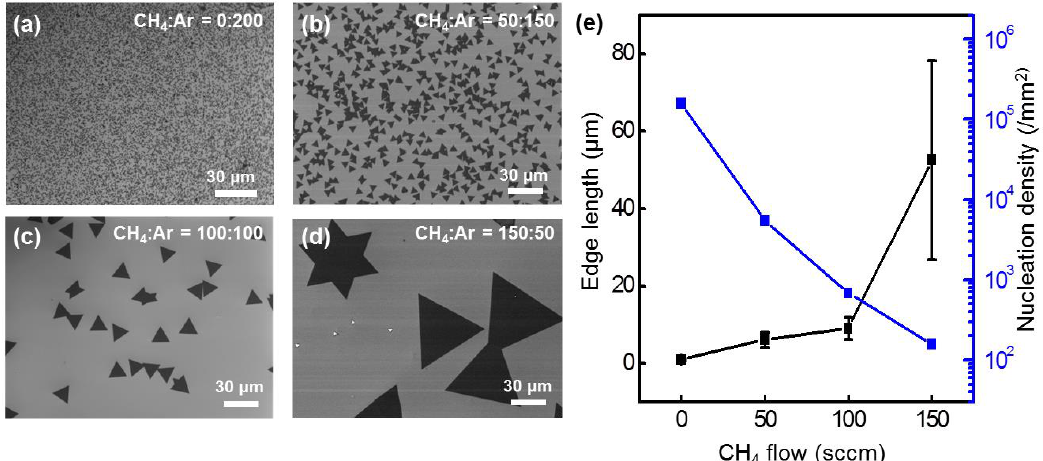
Figure 2. Size control of the WSe 2 domain by tuning the methane carrier gas ratio. Typical SEM images of WSe 2 grains synthesized on a SiO 2 / Si substrate with a flow of ( a ) CH 4 :Ar = 0:200, ( b ) CH 4 :Ar = 50:150, ( c ) CH 4 :Ar = 100:100, and ( d ) CH 4 :Ar = 150:50 sccm. ( e ) Edge length (black) and nucleation density (blue) of WSe 2 domains as a function of the CH 4 gas ratio. The error bars represent the edge length variations of WSe 2 domains obtained at the same CH 4 gas flow.